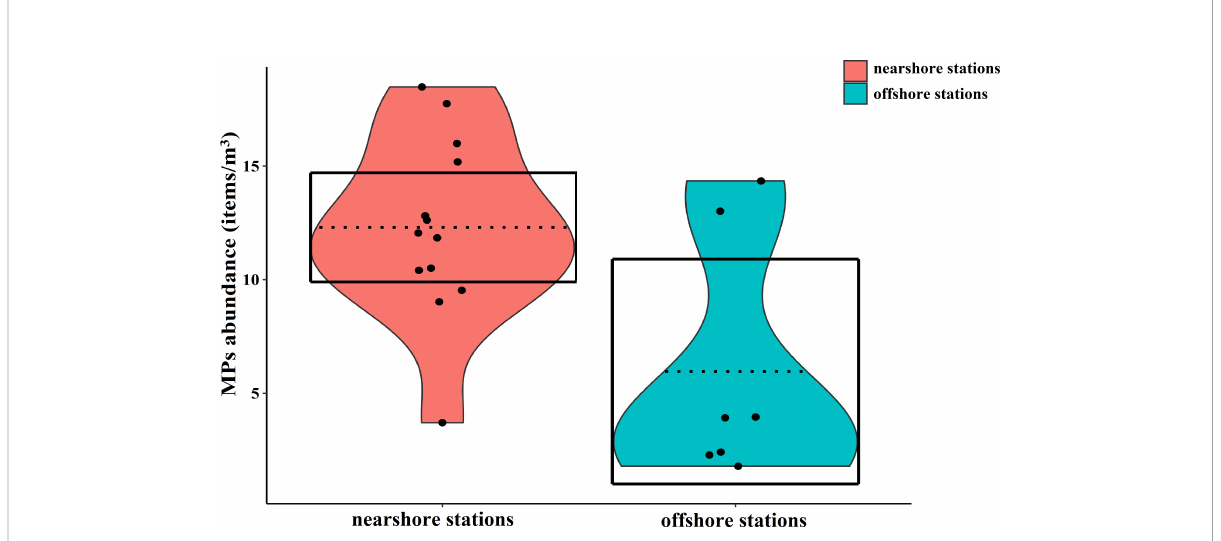
FIGURE 5 Comparisons of MPs abundance in the surface waters of the nearshore and offshore stations. The points represent the abundance of MPs, and the dashed lines represent the average abundance. The shapes fi lled with red and blue colors were on behalf of the smoothed densities, and the boxes represent the 95% inference